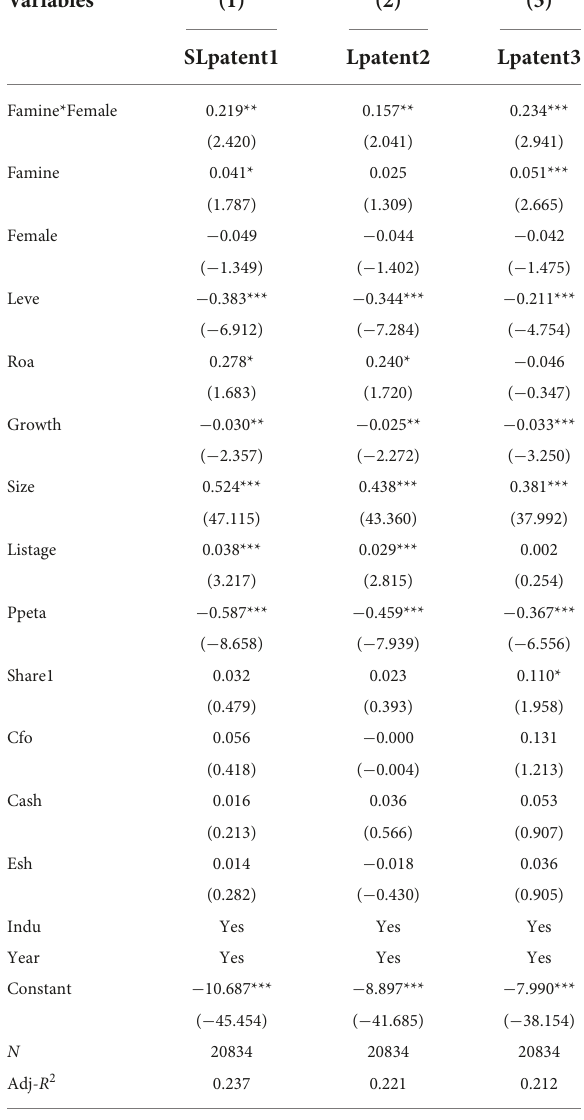
TABLE 5 Regression results of moderating effects under gender